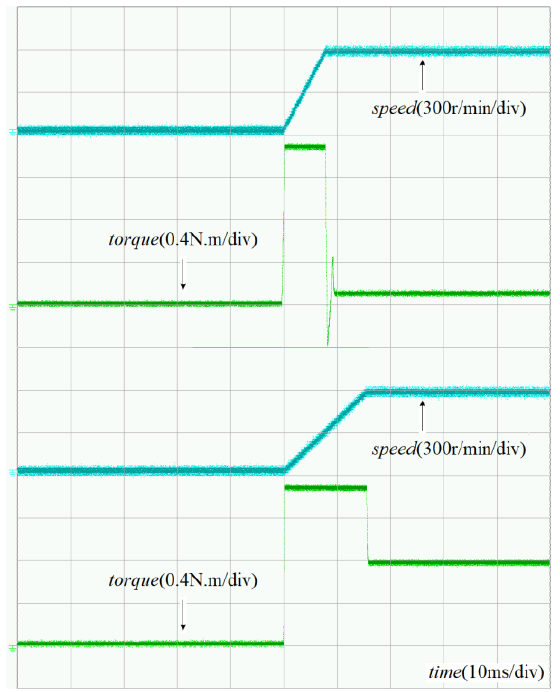
Figure 19. Speed and torque responses of the motor.